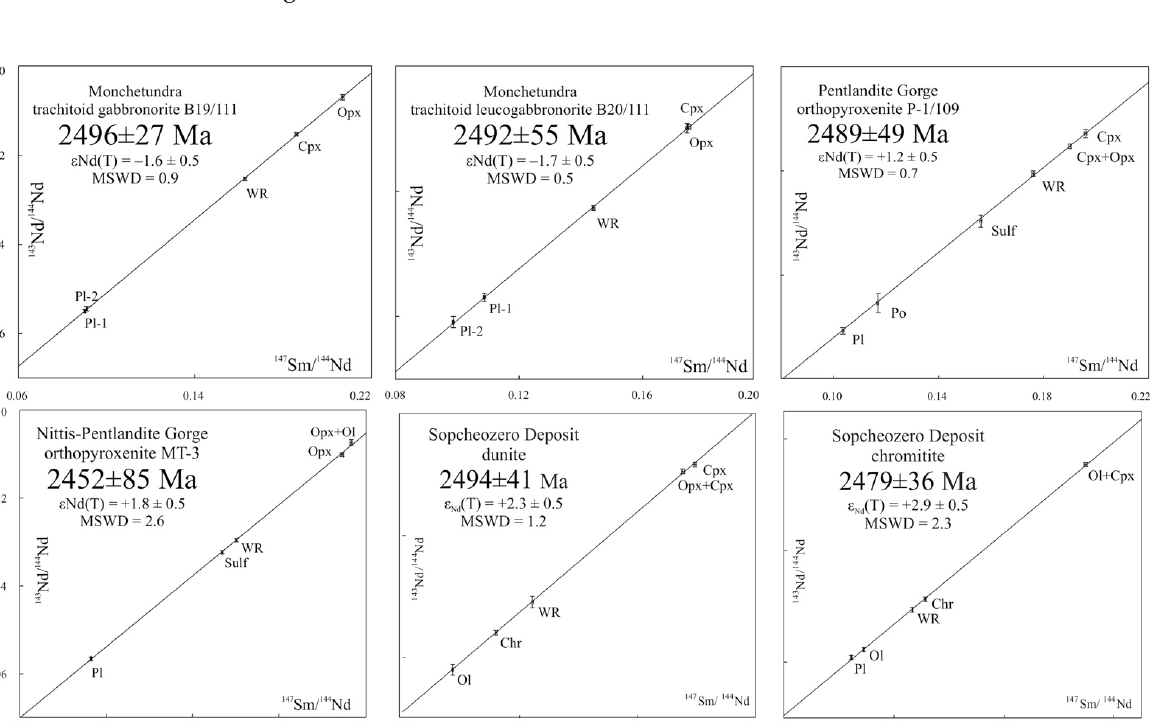
Valley (sample P-1/109) − 2489 ± 49 Ma, ε Nd(T) = +1.2 within the limits of